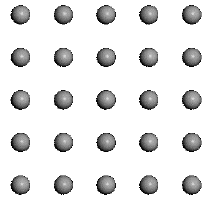
Figure 2. Atoms configuration of Cu nanoparticles.